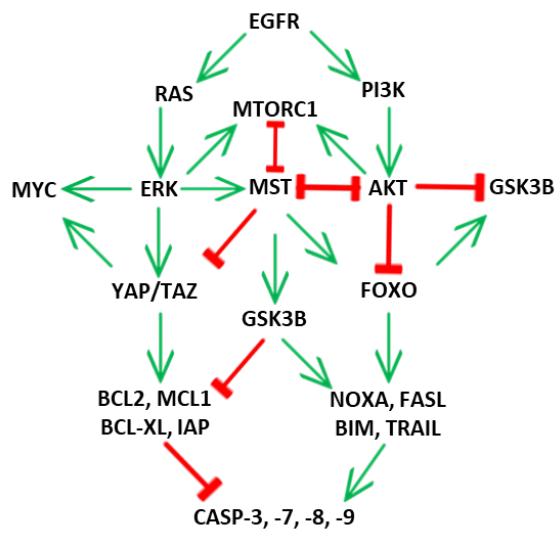
Figure 3. Cross-talk of the mitogen-activated protein kinase (MAPK)/ERK signaling pathway and mechanism of cell death induction through the ERK-Hippo interplay.